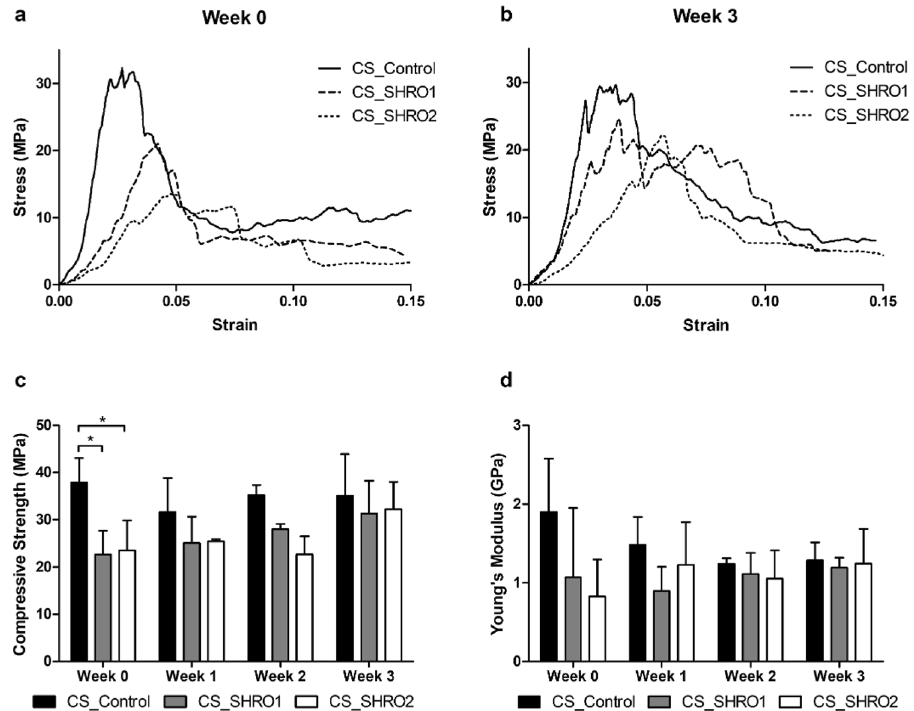
Figure 3. Average compressive stress vs. strain curves for CS_Control, CS_SHRO1 and CS_SHRO2 cements ( a ) as prepared (Week 0) and following ( b ) 3 weeks of static ageing in distilled water (n = 3). ( c ) Compressive strength and ( d ) Young’s modulus properties for CS_Control, CS_SHRO1 and CS_SHRO2 cements as prepared (Week 0), and following 1 week, 2 weeks and 3 weeks of static ageing in distilled water (Week 1, Week 2 and Week 3 respectively) (mean ± SD, n = 3) (GraphPad Prism